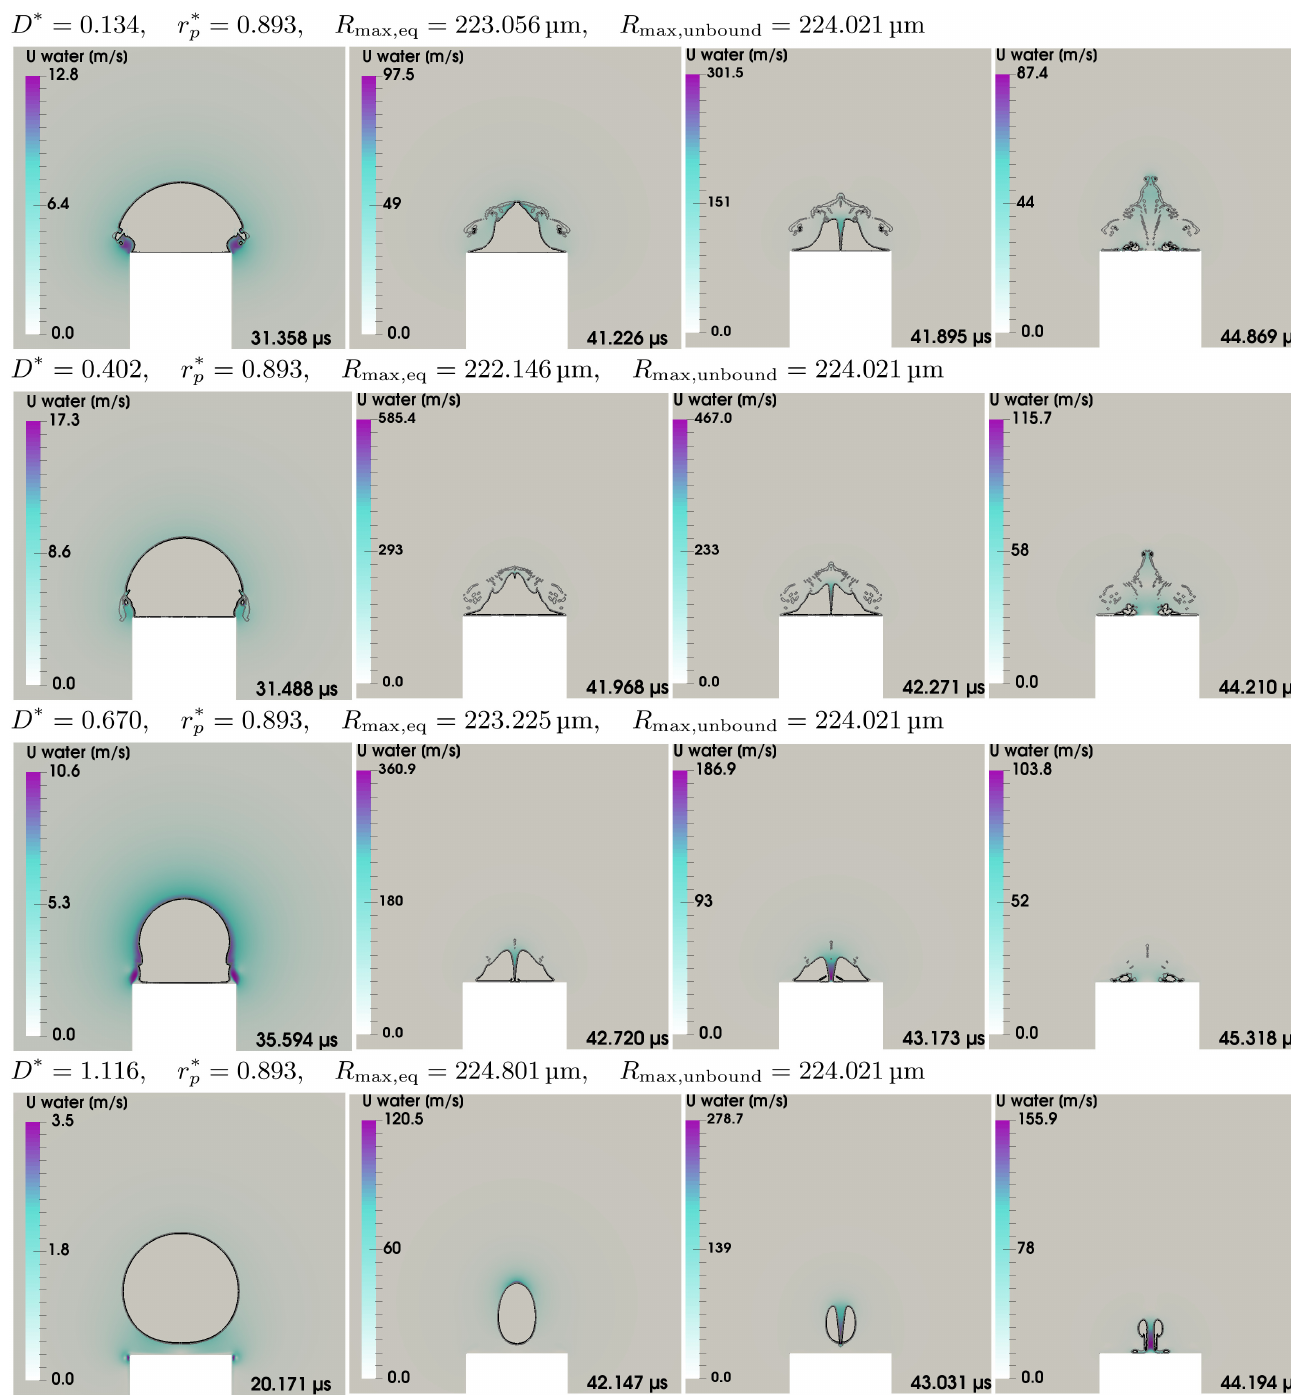
Figure A4. Mushroom bubble at r ∗ p = 0.893 for two different normalized distances D ∗ with the same R max,unbound . Very small overlap at maximum volume of the bubble over the pillar rim, no overlap for D ∗ = 1.116. The mushroom shape is gradually abandoned with increasing distance of the bubble from the pillar top. At least the jet in the last row is a standard jet with involution of the distal part of the bubble and not by annual inflow with self-impact. Cylinder radius is